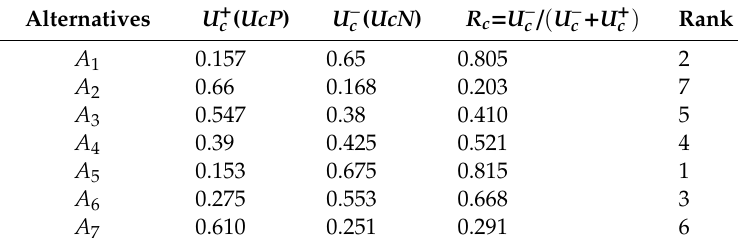
Table 15. Calculation of Relative Closeness Coe ffi cient (Final Ranking).